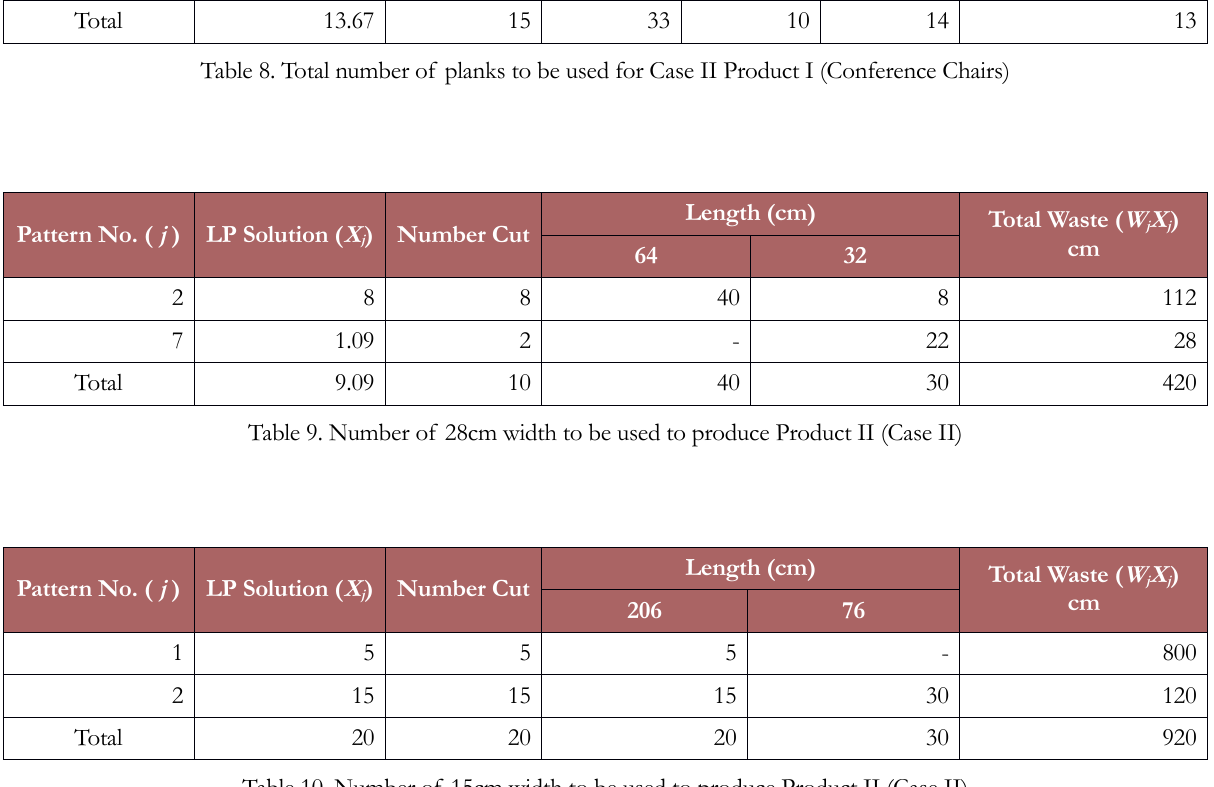
Table 10. Number of 15cm width to be used to produce Product II (Case II)